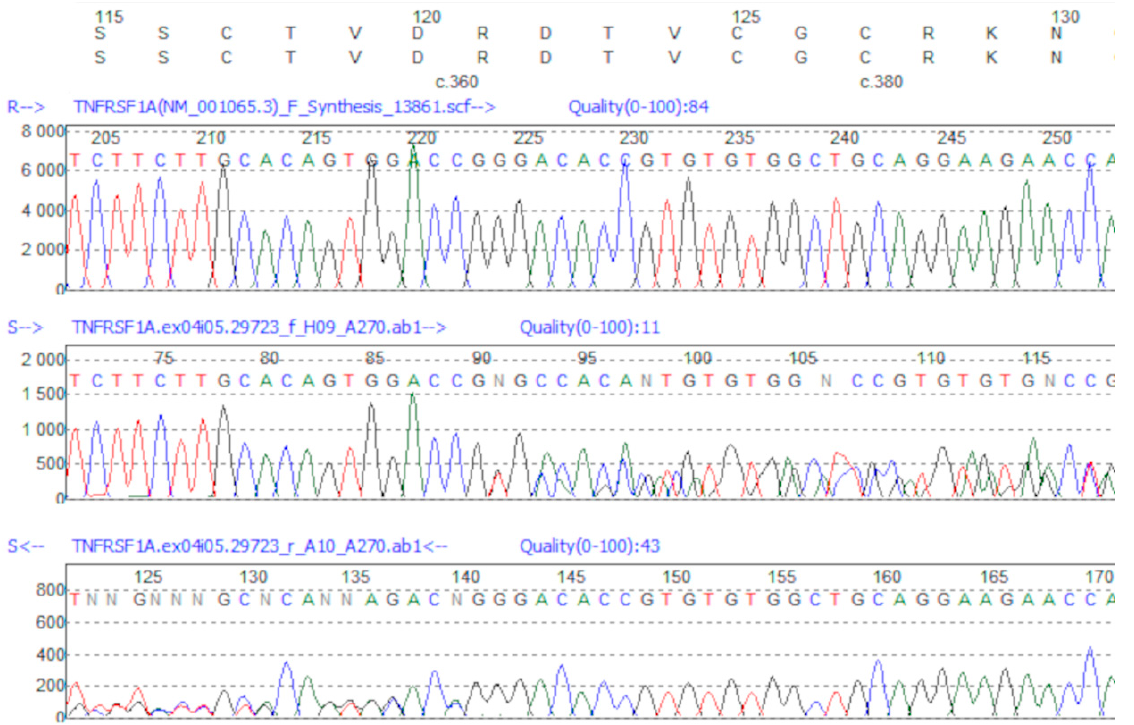
Figure 1. Sanger sequencing of NM_001065.5:c.362_363insTGCAAGACACAG variant. The alignment to wild sample sequence is visualized using Mutation Surveyor Software, v.4.0.7 (Softgenetics, State College, PA 16803, USA). The upper panel represents the reference sequence, underneath—Sanger sequencing of mutated sample—from forward (middle panel) and from reverse (bottom panel) primers.